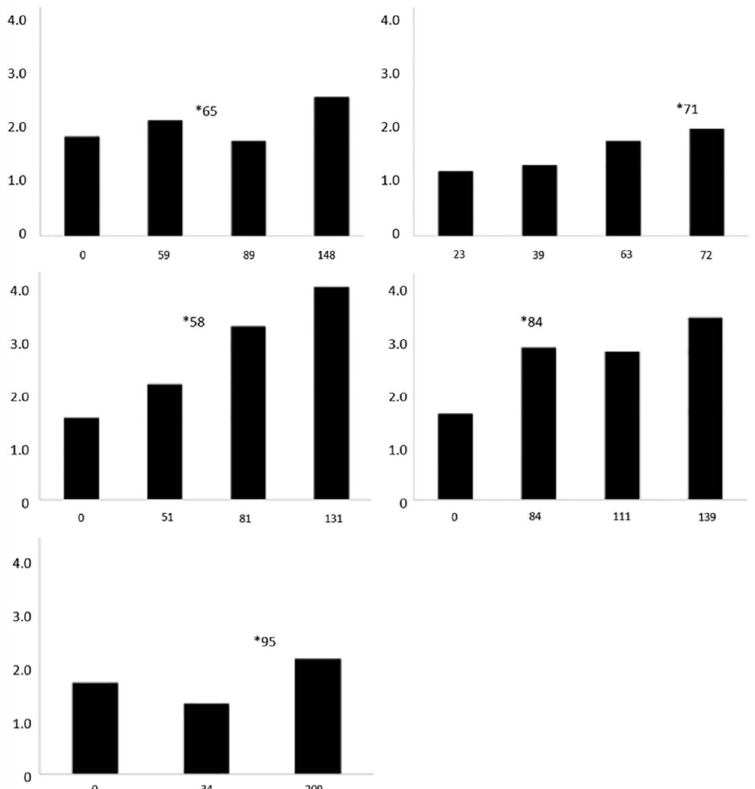
Figure 5. Thiobarbituric acid reactive substances (TBARS) plasma concentrations over time in individual cold-stunned Kemp’s ridley sea turtles ( Lepidochelys kempii ) with steatitis. The X -axis is days of rehabilitation, and the Y -axis is plasma TBARS concentrations in nmol/g. * represents the day of diagnosis of steatitis.